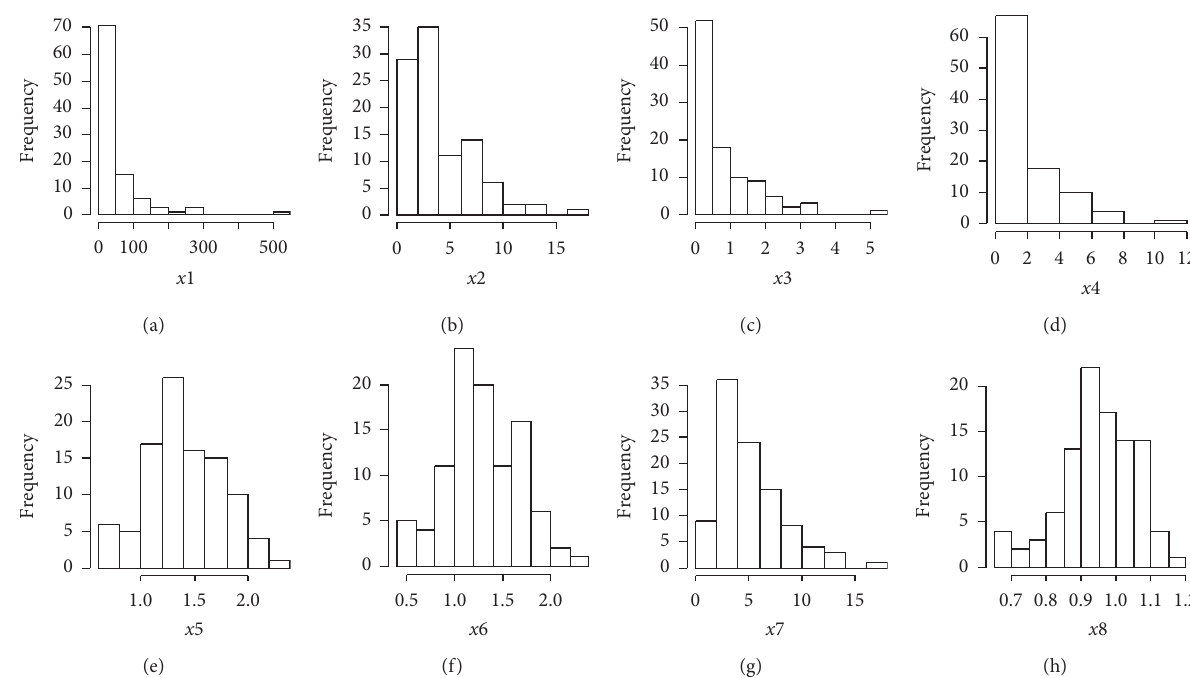
Figure 2: Histogram of EEDL distribution with various parameter values. (a) α � 1.5, β � 2.5, c � 1.5, ϕ � 3.5, u � 0.5, and q � 1, (b) β � 4.5, c � 1.5, ϕ � 2.5, u � 0.9, and q � 2.6, (c) β � 4.5, c � 1.5, ϕ � 2.5, and u � 0.9, (d) β � 0.5, c � 0.5, ϕ � 0.8, and u � 1.6, (e) ϕ � 2.5, u � 3.5,